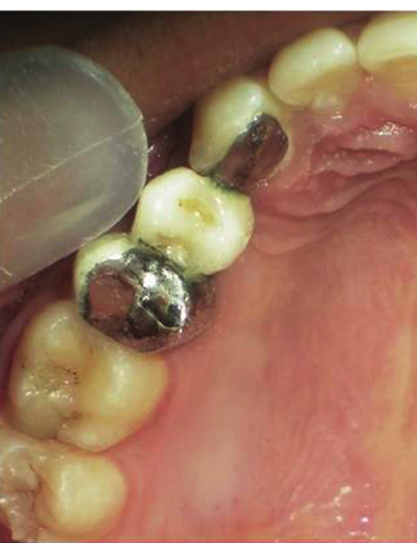
Figure 25: Luted in place porcelain fused to metal prosthesis fabricated by a conservative approach to replace 24.